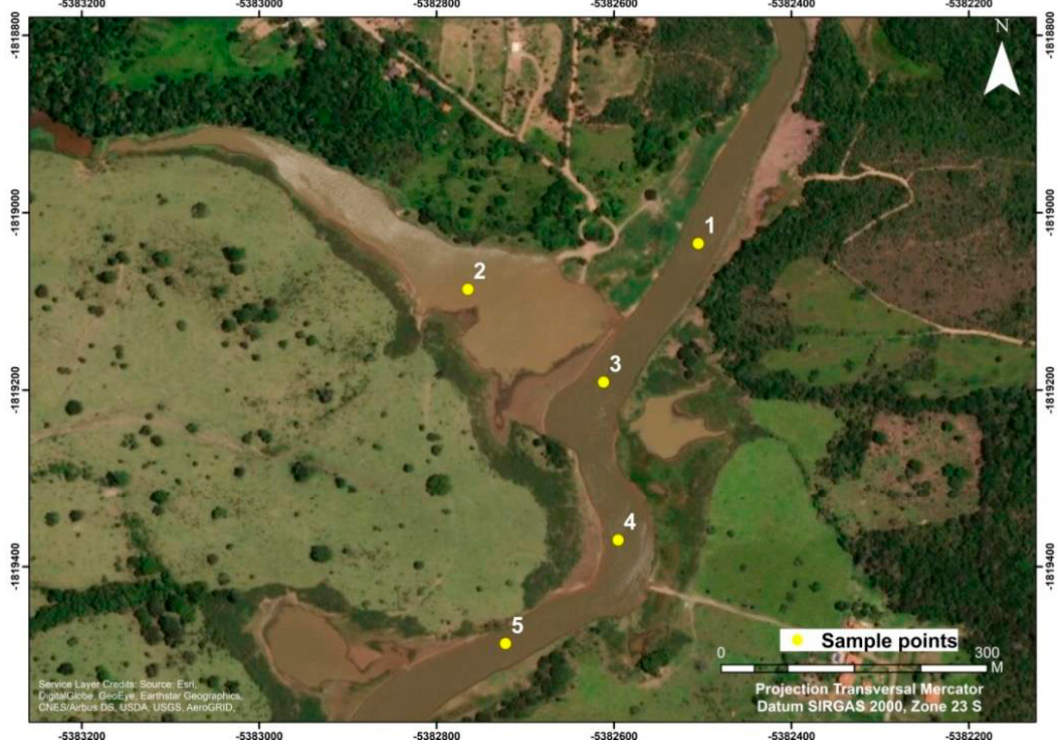
Figure 4. Location map of the inlet area between the Areias River and the Corumb á IV reservoir highlighting the in situ data sample points. Table 1. Sequoia camera and specifications of the multispectral bands and RGB